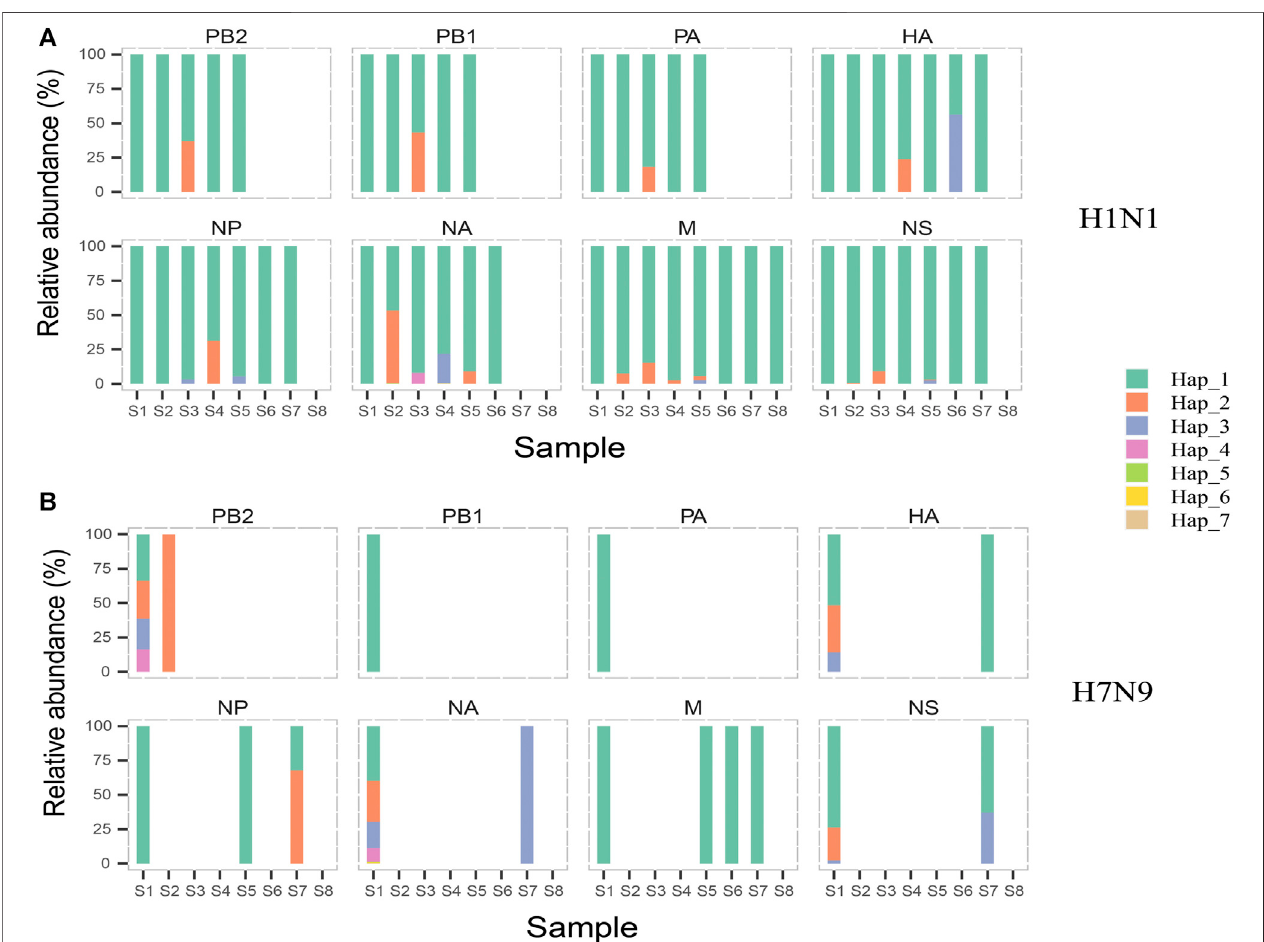
FIGURE 3 | The composition and dynamics of H1N1 and H7N9 virus quasispecies. In H1N1 (A) or H7N9 (B) , eight subgraphs respectively eight genomic segments of in fl uenza A virus. In each subgraph, different colors indicate different haplotypes. In the same subgraph, the same color represents the same haplotype, while in different subgraphs, same color is irrelevant. The forming and abundance of each haplotype are listed in Supplementary Table S4 .